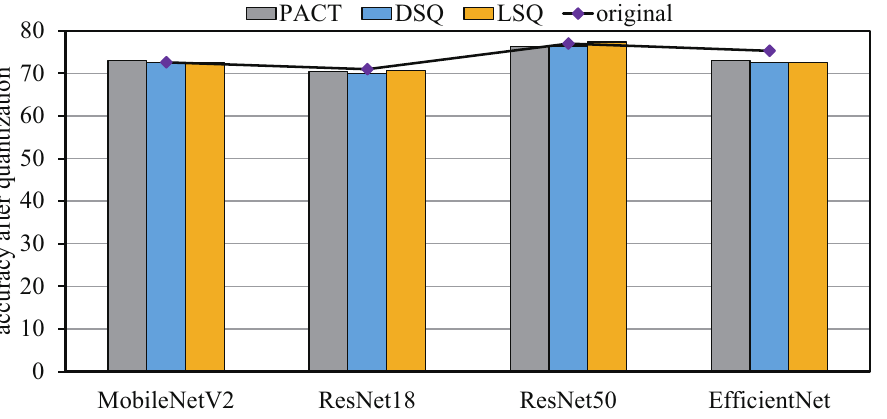
Figure 2. Model quantization comparison using different methods at 4-bit precision. Original line indicates the accuracy without